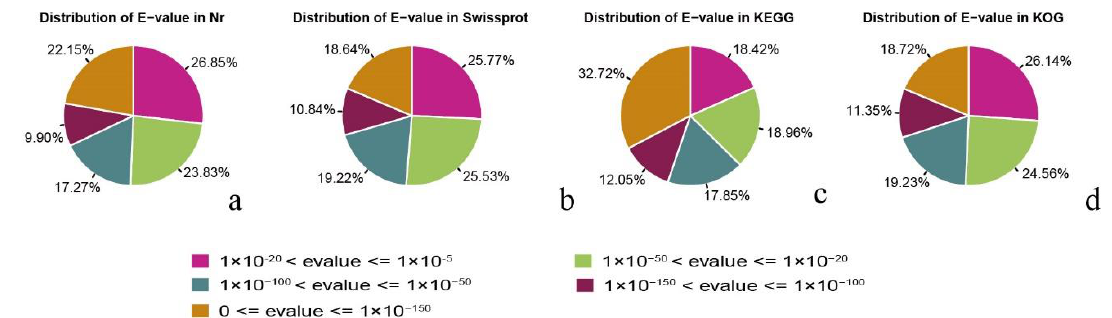
Figure 3. E-value distribution of top BLASTx hits against four protein databases for each unigene. ( a ) distribution E-values in non-redundant protein database; ( b ) distribution E-values in Swiss-protein database; ( c ) distribution E-values in the Kyoto Encyclopedia of Genes and Genomes database; ( d ) distribution E-values in the Eukaryotic Orthologous Group database.